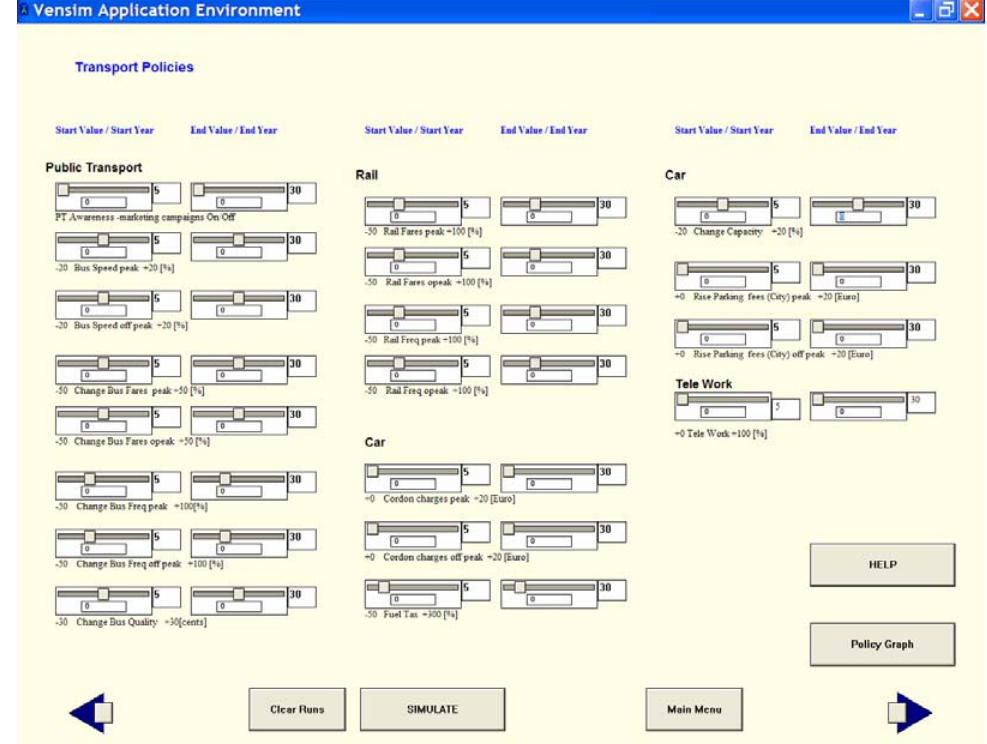
Figure 12. Example of flight simulator front-end for MARS